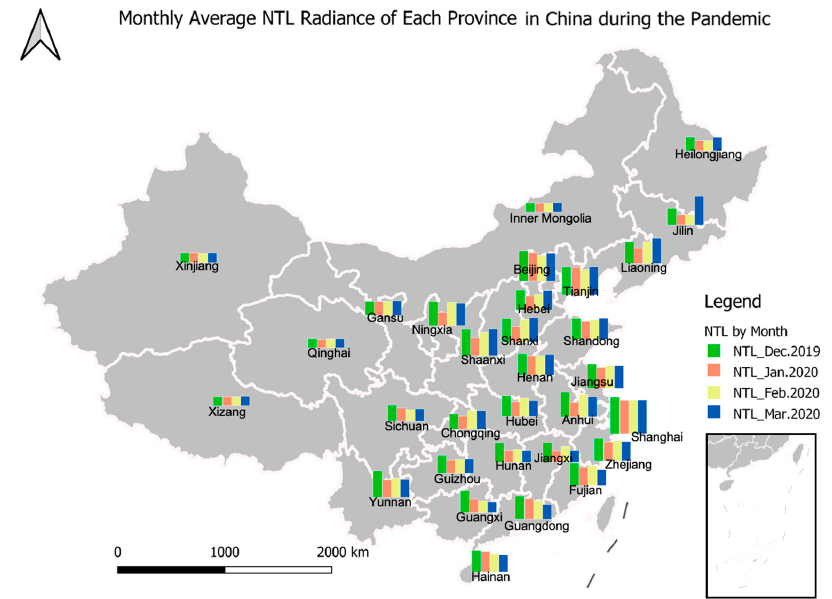
Figure 2. Monthly average NTL for each province from December 2019 to March